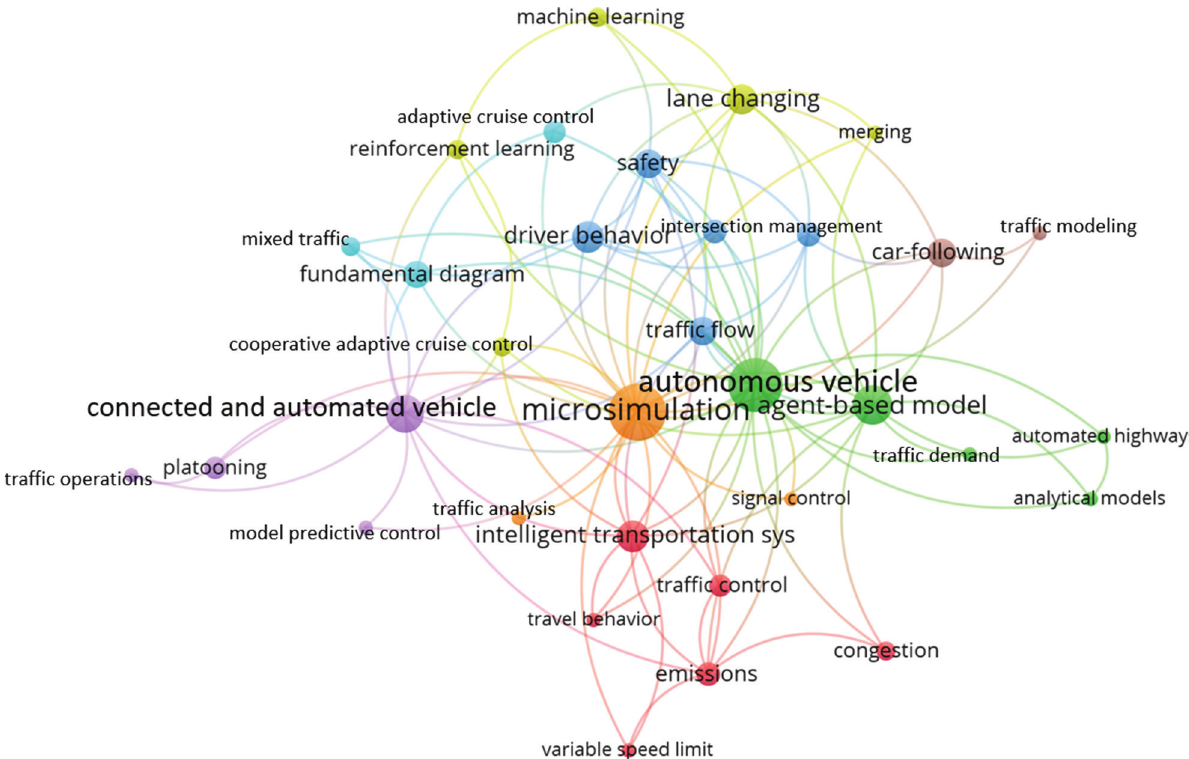
Figure 6: Keyword network of AV microsimulation